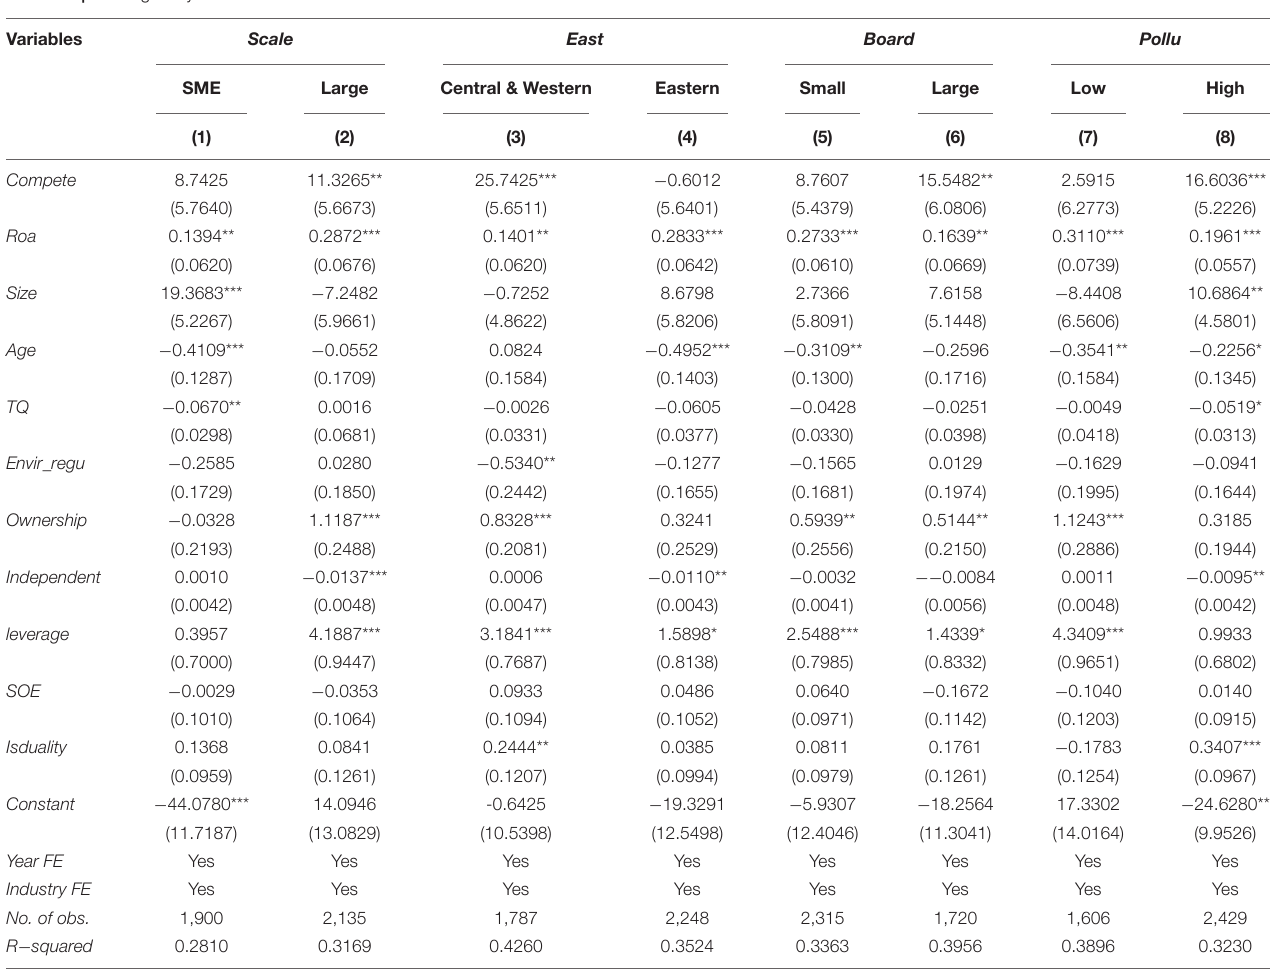
TABLE 3 | Heterogeneity